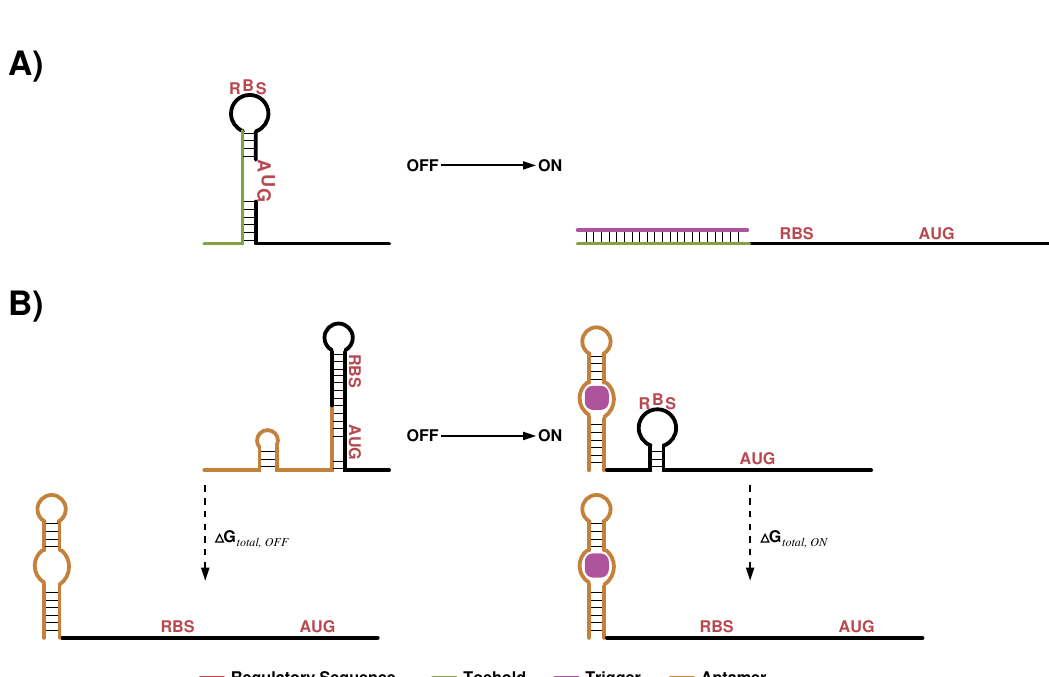
Figure 6. Cartoons to illustrate design ideas of recently published approaches to regulate translation. In ( A ) the approach utilized by Green et al. [120] is shown. The novelty of this design attempt was to place the RBS and AUG of the regulated downstream gene into loop regions of a structural element, which can be opened by binding to a toehold sequence. ( B ) depicts an aptamer based design developed by Espah-Borujeni et al. [121]. The Salis lab developed over recent years a detailed biophysical model to predict the energy ∆ G total , which is necessary to open up structural elements that interfere with ribosome binding. This is applied in order to ensure that low gene expression is observed in the OFF and high values are detected in the ON state. Hence ∆ G total , OFF needs to be high and ∆ G total , ON